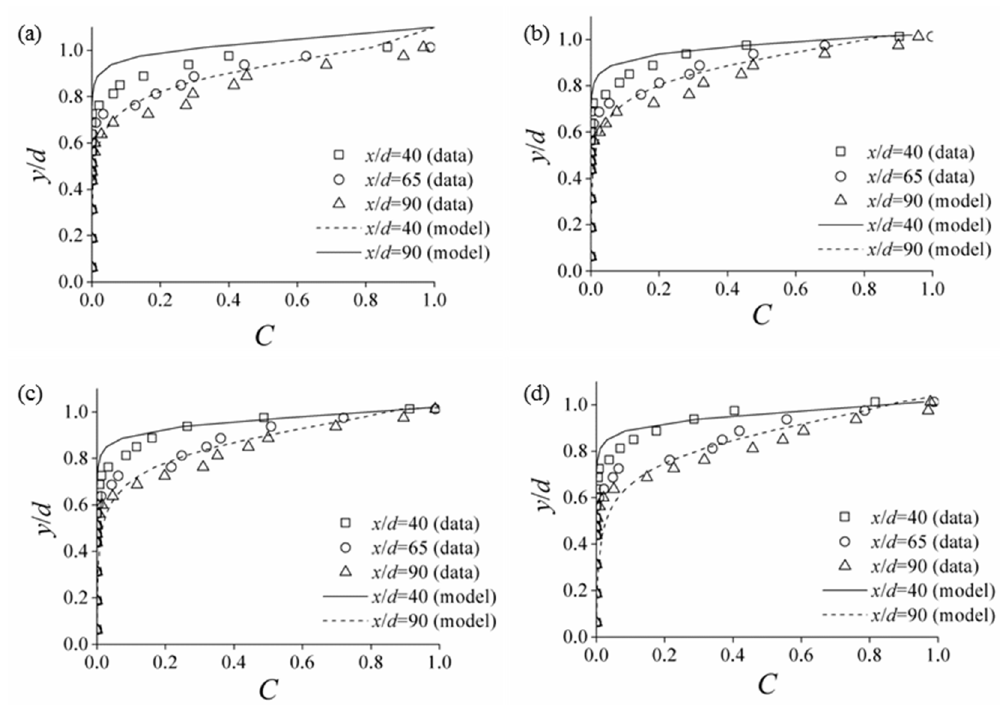
Figure 4. Air concentration distributions in cross-sections: ( a ) Fr 0 = 6.353; ( b ) Fr 0 = 6.706; ( c ) Fr 0 = 7.059; ( d ) Fr 0 = 7.412.